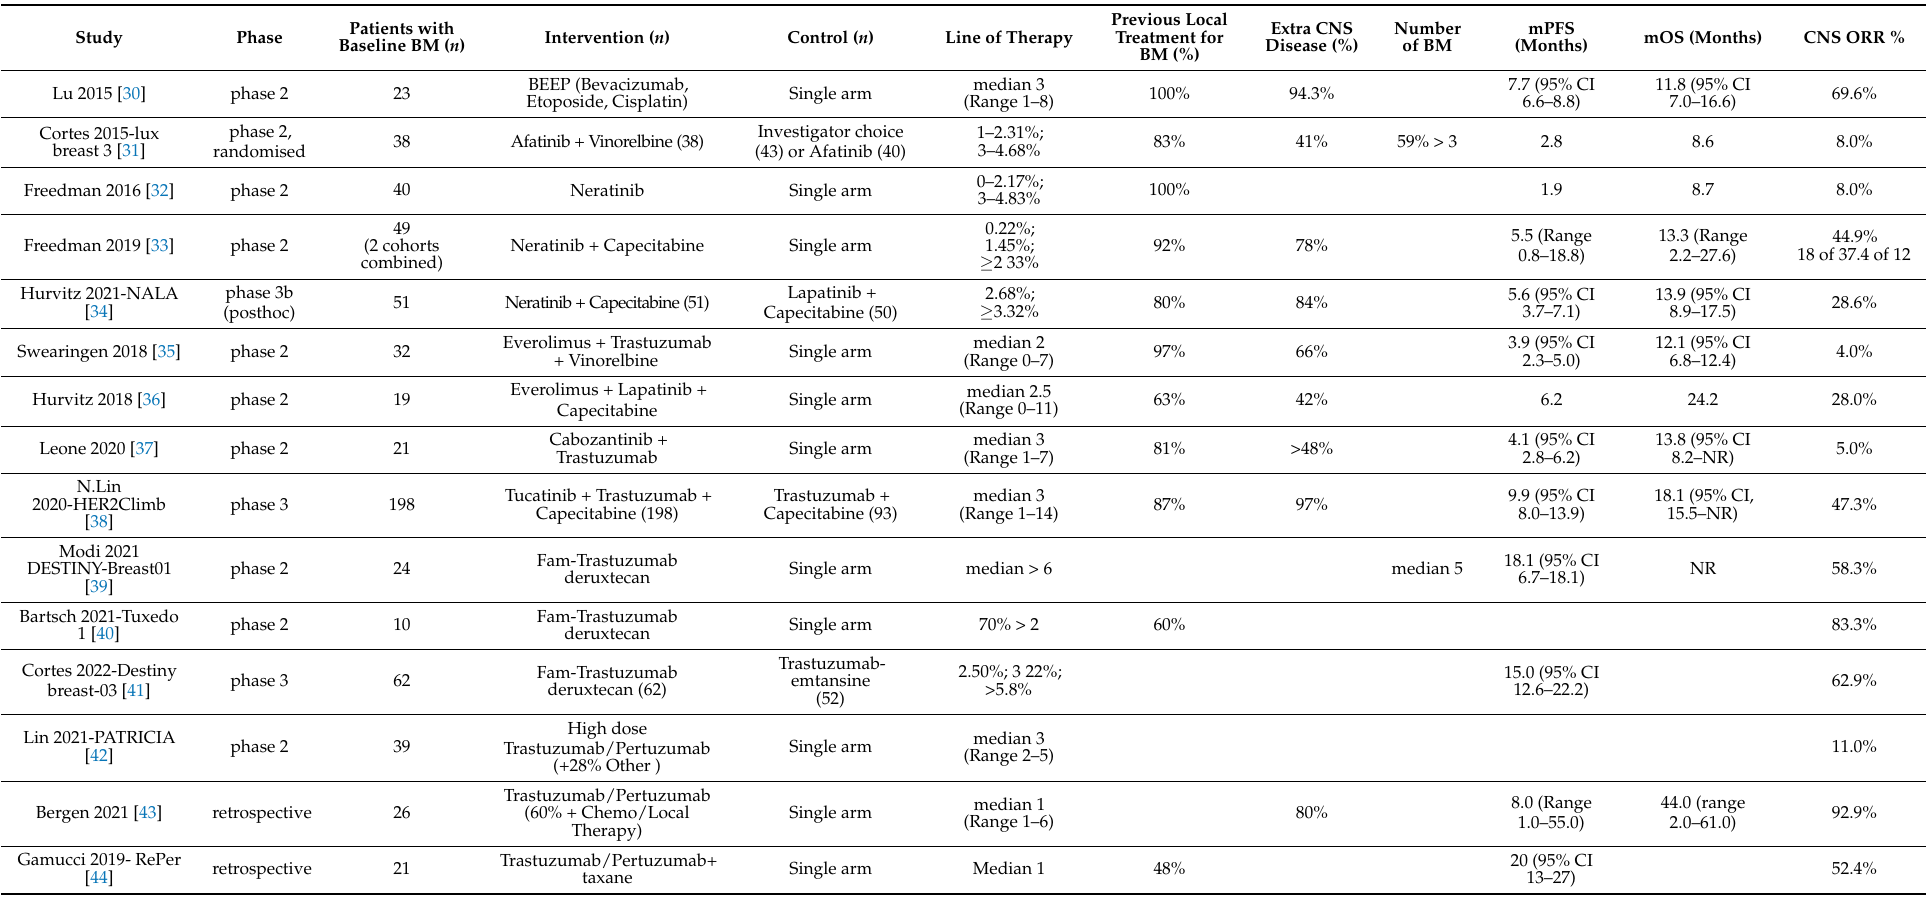
Table 1. Characteristics of included studies on BEEP, afatinib, neratinib, everolimus, cabozantinib, tucatinib, T-Dxd and trastuzumab/pertuzumab ( N =